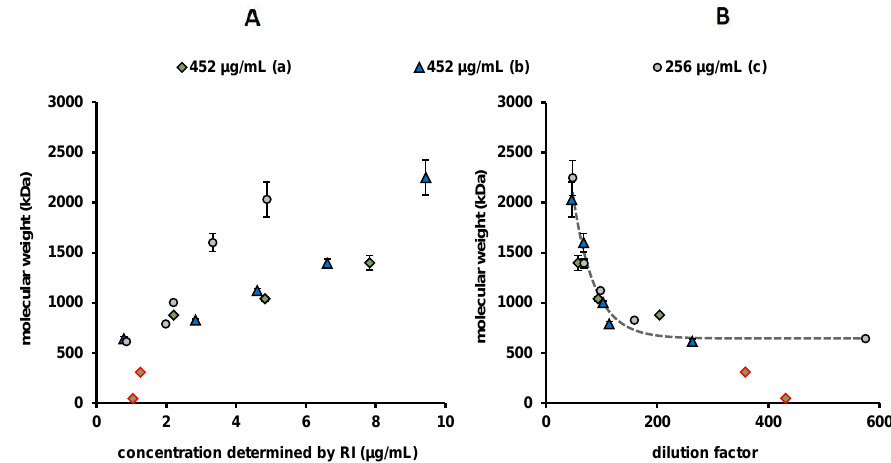
Figure 9. ( A ) Weight-average molecular weights (M w ) of BMP-2 injection series a, b and c into MES buffer, determined by MALS/dRI. The error bars indicate standard deviation of the determined molecular weights given by Debye fitting. ( B ) M w of the injection series in correlation to the dilution factor (concentration determined by dRI/concentration before injection). Dotted line indicates an exponential decrease fit of b and c. The two very first injections are marked in red. To check whether BSA may decrease the aggregation tendency of BMP-2, HSA stock solution was added to the BMP stock solution (both in MES buffer) in order to reach concentrations of BMP-2 and HSA of 0.20 and 1.15 mg/mL, respectively. This corresponded to molar concentrations of 7.7 µmol/mL BMP-2 and 15.1 µmol/mL HSA. As a control, HSA solution in MES (1 mg/mL) was used. Two injection series each into PBS buffer were carried out (Figure 10). Between each of the two measurement series, the proteins in MES pH 5 were stored at 4–8 °C for 24 h. The mean value for the determined weight average-molecular weight of the in total 10 injections of HSA alone was 62.7 ± 2.2 kDa (M w /M n = 1.025 ± 0.012), i.e., approximately equivalent to the expected molecular weight of 66.4 kDa, and showed no concentration or overnight storage correlated alteration. For the HSA/BMP-2 mixtures, molar masses and polydispersity (M w /M n ) increased with increasing injected mass, e.g., lower dilutions from 1.027 to 1.099 (c). The concentration-correlated increase of the M w , highlighted by the dotted line in Figure 10, and the increase of polydispersity was more prominent for the first injection series.